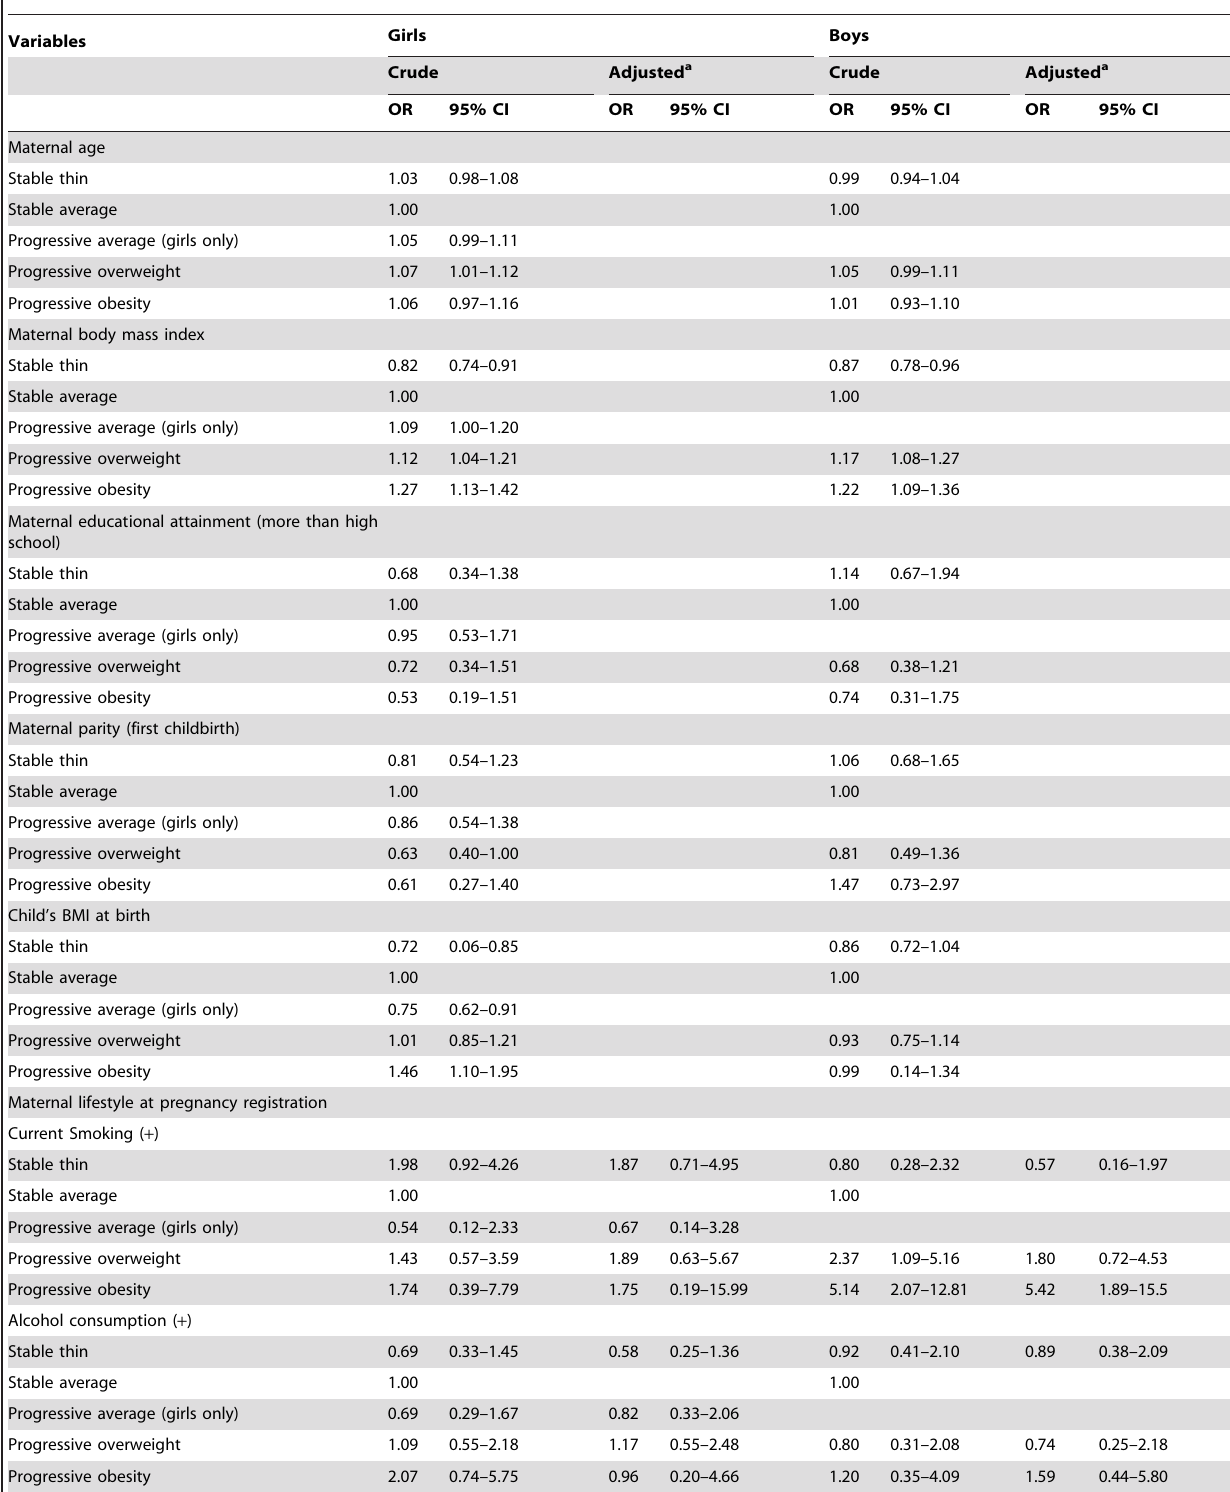
Eating habits: Skipping breakfast ( + )